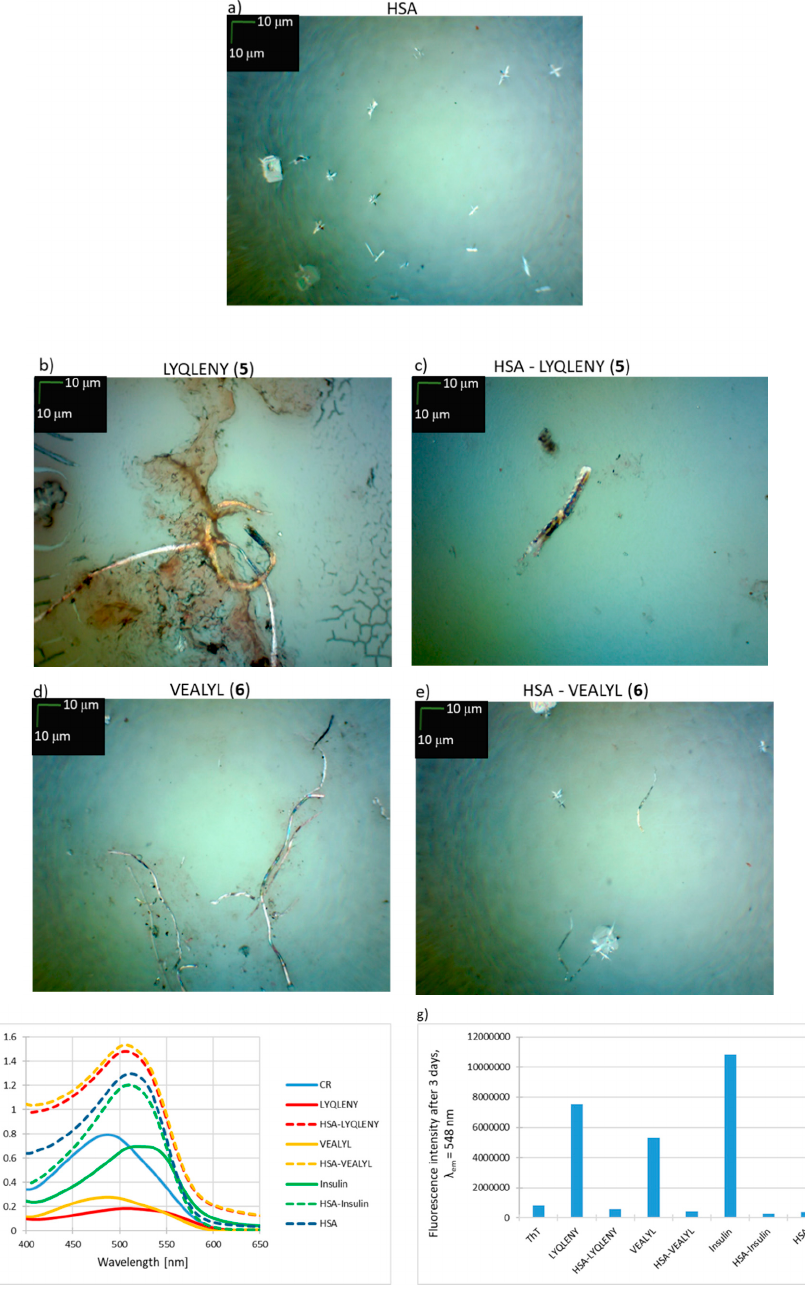
Figure 11. The results of studies on the susceptibility of complexes of HSA with insulin and its hot spots 5 and 6 to aggregation. Microscopic examination for: ( a ) HSA, ( b ) H-LYQLENY-OH (5), ( c ) HSA-LYQLENY, ( d ) H-VEALYL-OH (6), ( e ) HSA-VEALYL. Scale bars, 10 µm, microscopic measurements were performed on the third day of incubation. ( f ) UV-Vis spectra of insulin, peptides 5 and 6 , HSA, complexes of HSA with insulin, and peptides 5 and 6 in the presence of Congo Red (CR). ( g ) Intensity of fluorescence of insulin, peptides 5 and 6 , HSA, complexes of HSA with insulin and peptides 5 and 6 in the presence of Thioflavin T (ThT), after the third day of incubation.